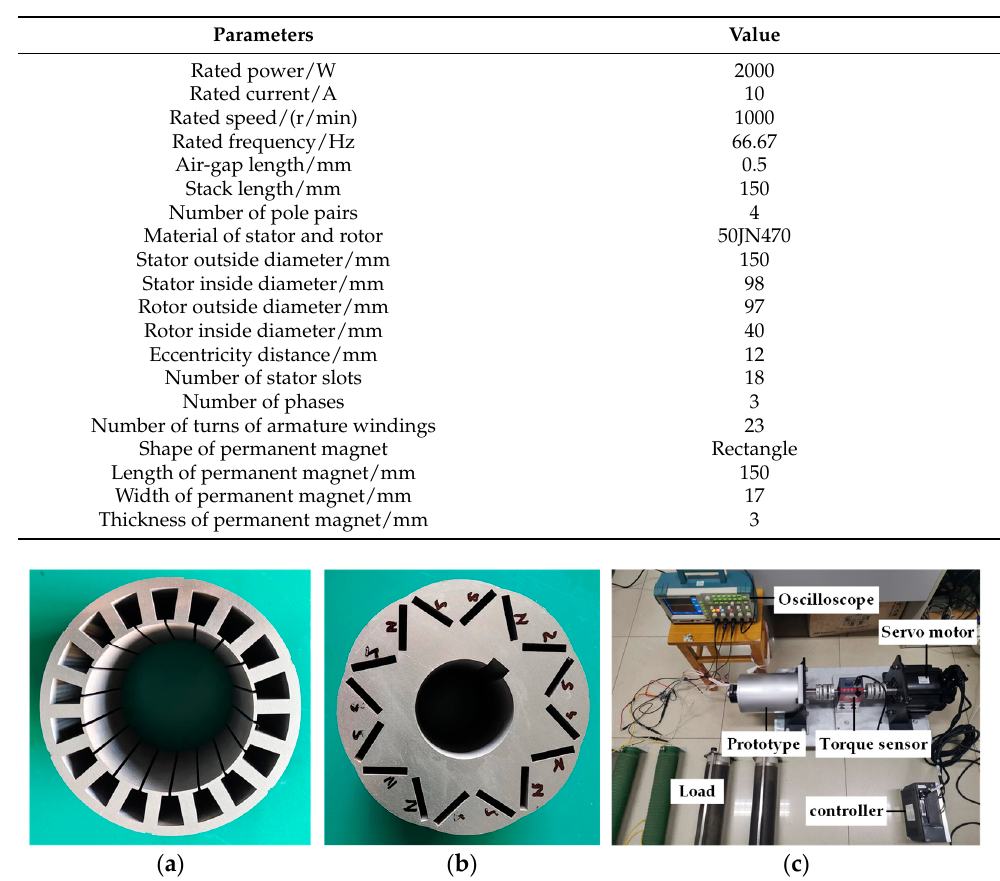
( b ) Figure 18. Waveforms of back-EMF at no load: ( a ) measured waveform and ( b ) comparison of finite element simulation and experimental waveforms of A, B, C three phases of the back-EMF. For purpose of verifying the torque characteristics of the motor, the load test of the prototype was carried out at a rated speed of 1000 r/min. The FEA calculated and meas- ured electromagnetic torque of the machine at rated speed are shown in Figure 19a. The FEA calculated output torque at rated speed of 1000 r/min is 20.41 Nm, and the measured input torque is 21.41 Nm. Since there are some mechanical losses when the motor runs at no-load, there is a certain error between the measured input torque and output torque, but otherwise the measured result is almost consistent with the FEA calculated value, and 150